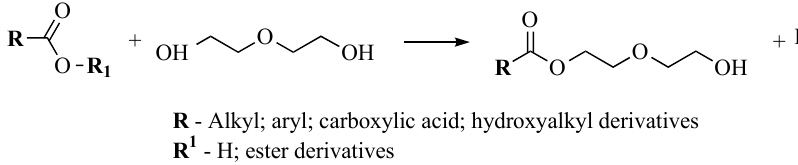
Figure 3. Representative reaction diagram to obtain bio-polyols from the SA.